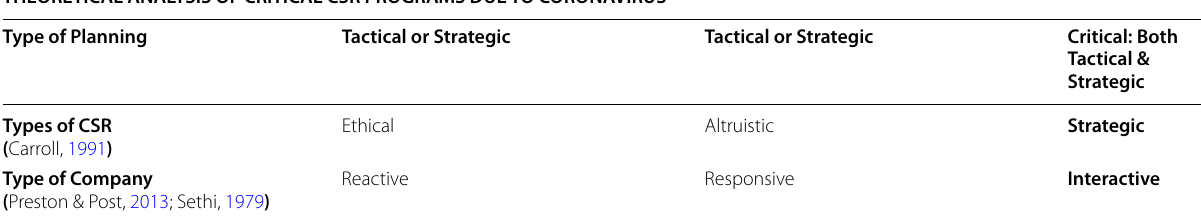
Table 3 Theoretical profile of Critical CSR THEORETICAL ANALYSIS OF CRITICAL CSR PROGRAMS DUE TO CORONAVIRUS Type of